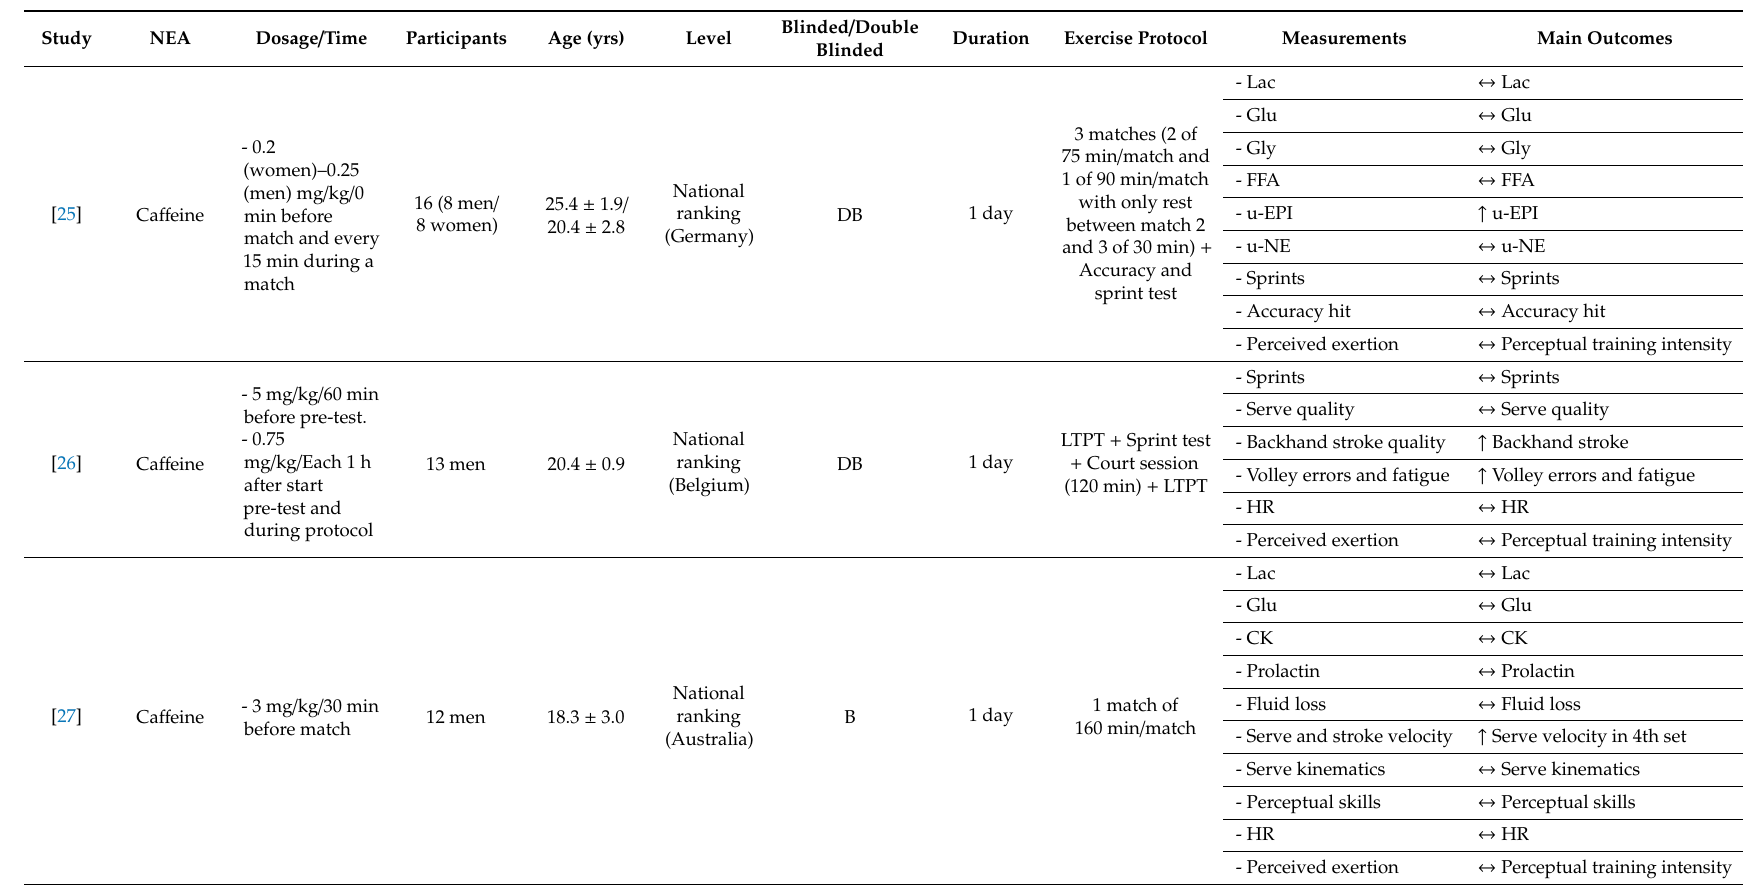
Table 2. Included studies on nutritional ergogenic aids in tennis. BCAAs: Branched-chain amino acids; FFA: Blood free fatty acids; Glu: Blood glucose; Gly: Blood glycerol; HR: Heart rate; Lac: Blood lactate; LTPT: Leuven Tennis Performance Test; LTST: Loughborough Tennis Skill Test; NO; Nitric oxide; Pl: Placebo; RSA: repeated-sprint ability shuttle test; STPT: Skill Tennis Performance Test; Trp / BCAAs: Blood tryptophan / branched-chain amino acids ratio; u-EPI: Urine epinephrine; u-NE: Urine norepinephrine. ↑ : Significant increase compared to placebo / control group; ↓ : Significant decrease compared to placebo / control group; ↔ : without changes compared to placebo / control